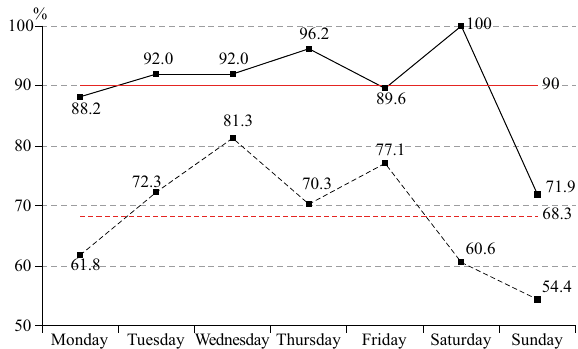
Fig. 3. Average number of trips made per day ( ); respondents living off the campus ( ); and in the campus ( )